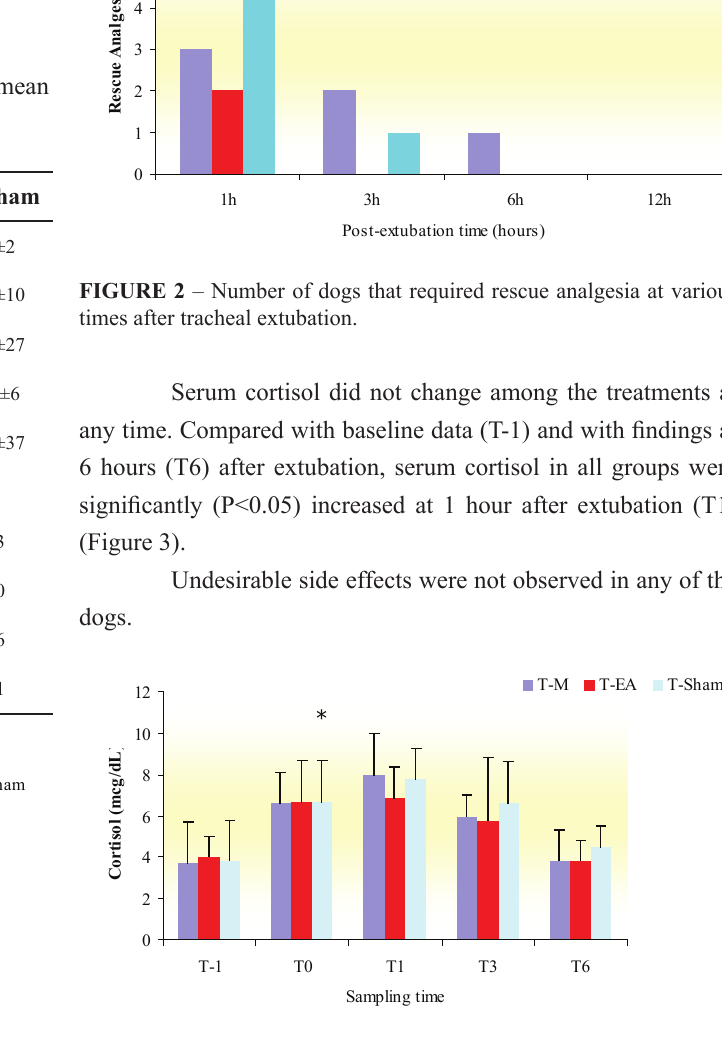
FIGuRE 3 - Mean±SD serum cortisol concentration in dogs treated with morphine (T-M), electroacupuncture (T-EA) or sham acupuncture (T-Sham). T-1, before pre-anesthetic medication; T0, 45 minutes after anesthetic induction; T1, 1 hour; T3, 3 hours; T6, 6 hours after tracheal